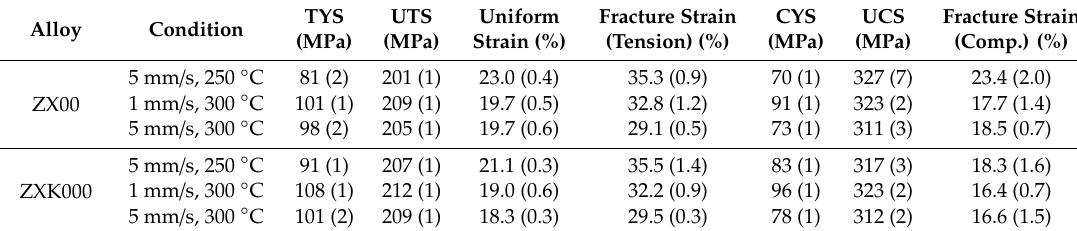
Figure 2. Stress–strain diagrams from tension (solid lines) and compression (dotted lines) tests at ambient temperature: ( a ) ZX00; ( b ) ZXK000. Table 3. Mechanical properties from tensile and compression tests in Figure 2a,b for ZX00 and ZXK000; TYS: tensile yield stress, UTS: ultimate tensile stress, CYS: compressive yield stress, UCS: ultimate compressive stress; errors in